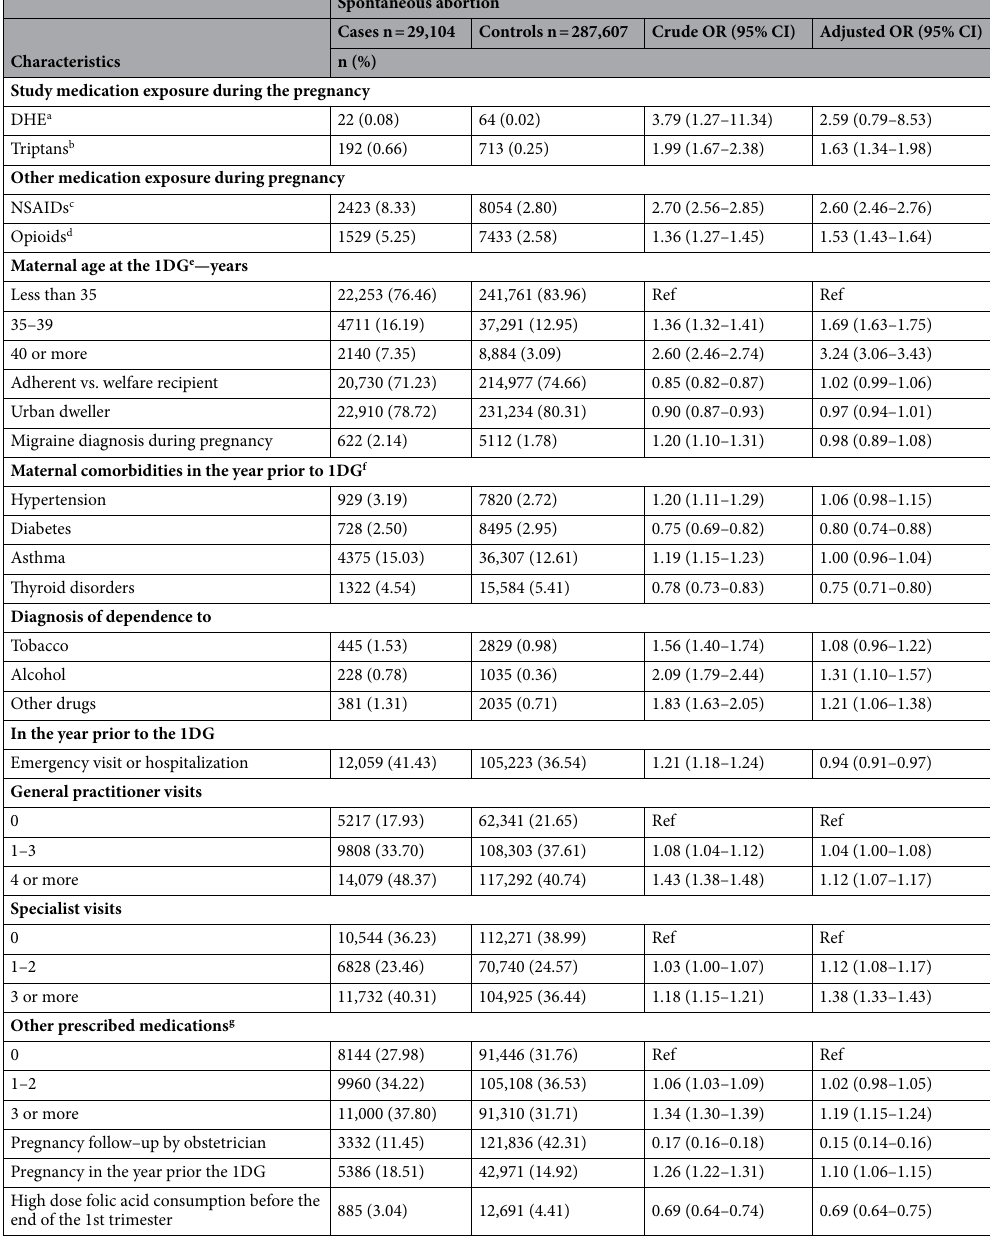
Table 6. Association between study medication exposure during pregnancy and the risk of spontaneous abortion. a Dihydroergotamine; b Including almotriptan, eletriptan, naratriptan, rizatriptan, sumatriptan, and zolmitriptan; c Including celecoxib, diclofenac, diflunisal, etodolac, fenoprophen, fentanyl, flurbiprofene, hydrocodone, hydromorphone, ibuprofen, indomethacin, ketoprofen, mefenamic acid, meloxicam, nabumetone, naproxen, piroxicam, rofecoxib, sulindac, tiaprofenic acid, tolmetin, and valdecoxib; d Including codeine, meperidine, morphine, oxaprozin, oxycodone, oxymorphone, pentazocine, tapentadol, propoxyphen, and tramadol. Note: Pregnant women can use more than 1 study medication during pregnancy. e First day of gestation defined as the first day of the last menstrual period; f Comorbidities were assessed in the year prior to the 1DG using ICD-9 and ICD-10 diagnosis codes and prescribed medications; g Other prescribed medications than the study medications and the medications used for the identification of the